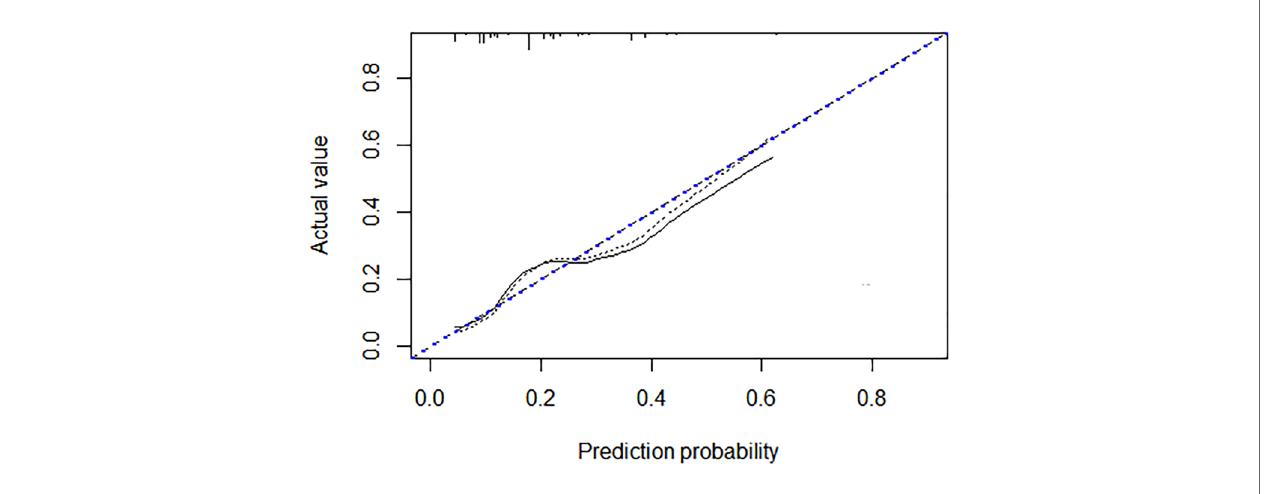
FIGURE 3 | Calibration plot of the nomogram using the validation cohort.